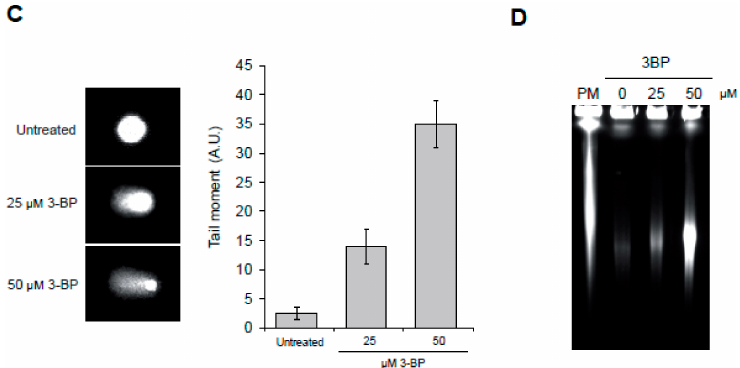
Figure 7. 3-BP induces DNA double-strand break formation in mammalian cells: ( A ) 3-BP decreases the viability of THP-1 cell line. THP-1 cells were treated with di ff erent 3-BP concentrations for 12 h and cell viability was assessed by trypan blue exclusion test. Error bars represent mean value ± standard deviations of mean ( n = 3). ( B ) 3-BP triggers DNA damage checkpoint activation in mammalian cells. Cells were treated with indicated concentrations of 3-BP for 12 h and processed for analysis of cells with phosphorylated histone H2A.X. ( C ) 3-BP induces formation of DNA breaks in THP-1 cells. THP-1 cells were treated with indicated concentrations of 3-BP for 12 h and then processed for alkaline comet assay. Representative images of comets are shown. Error bars represent mean value ± standard deviations of mean ( n = 3). ( D ) Exposure to 3-BP results in generation of DNA double-strand breaks. THP-1 cells were treated with indicated concentrations of 3-BP for 12 h. Next, intact chromosomes were isolated and processed for